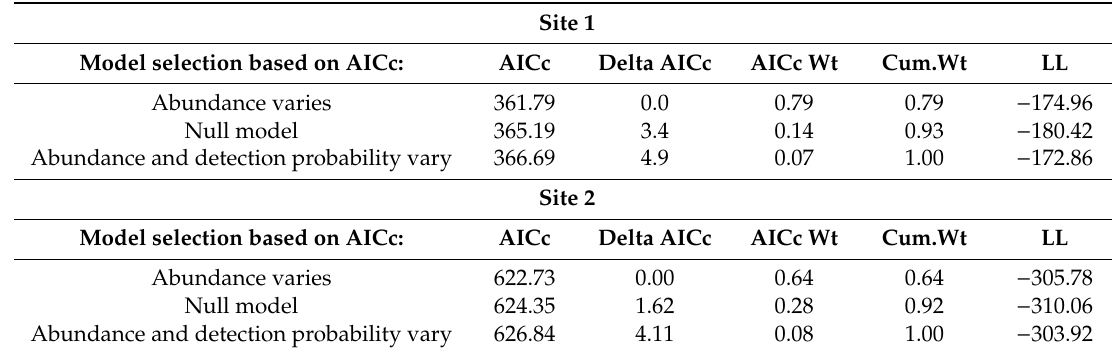
Table 2. Model selection based on Akaike information criterion that has a correction for small sample sizes (AICc), for Site 1 and Site 2, which includes abundance varying by habitat type (abundance varies), the null model (null), and both abundance and detection probability varying by habitat type (abundance and detection probability